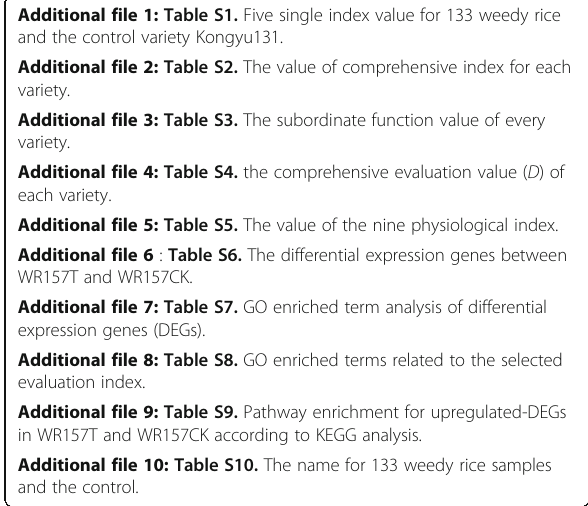
Additional file 10: Table S10. The name for 133 weedy rice samples and the control.